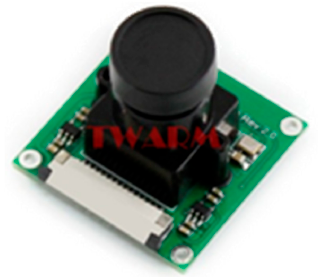
Figure 5. Camera. Figure 5. Figure 5. Camera.